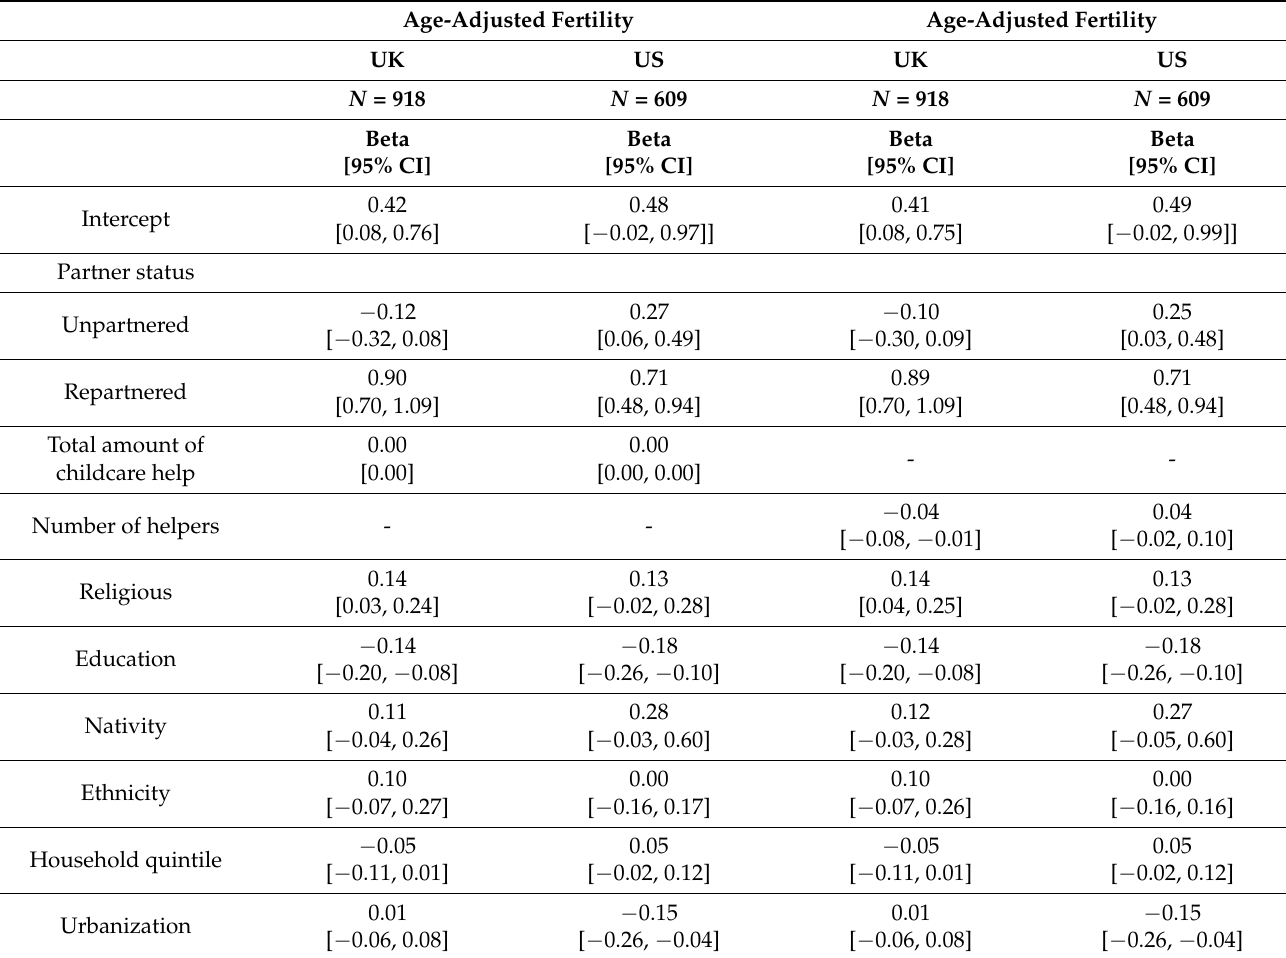
Table 6. Results of Bayesian regression models predicting age-adjusted fertility in the US and in the UK. Age-Adjusted Fertility Age-Adjusted Fertility UK US UK US Beta Beta Beta [95% CI] [95% CI] [95% CI] [95%